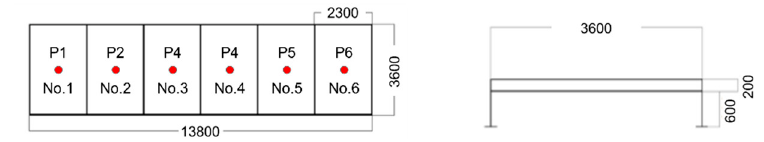
Figure 4. Slab model geometry (Unit: mm).